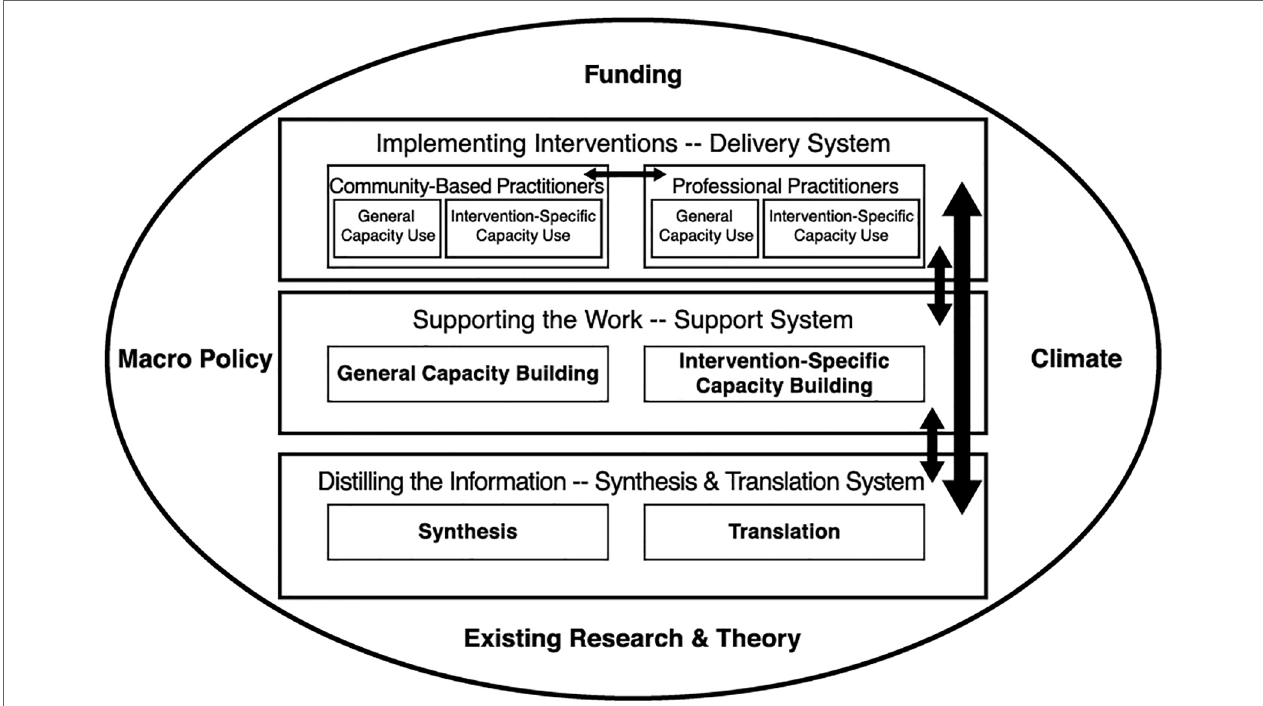
FIGURE 2 | The Interactive Systems Framework (14) with Inclusion of Community-Based